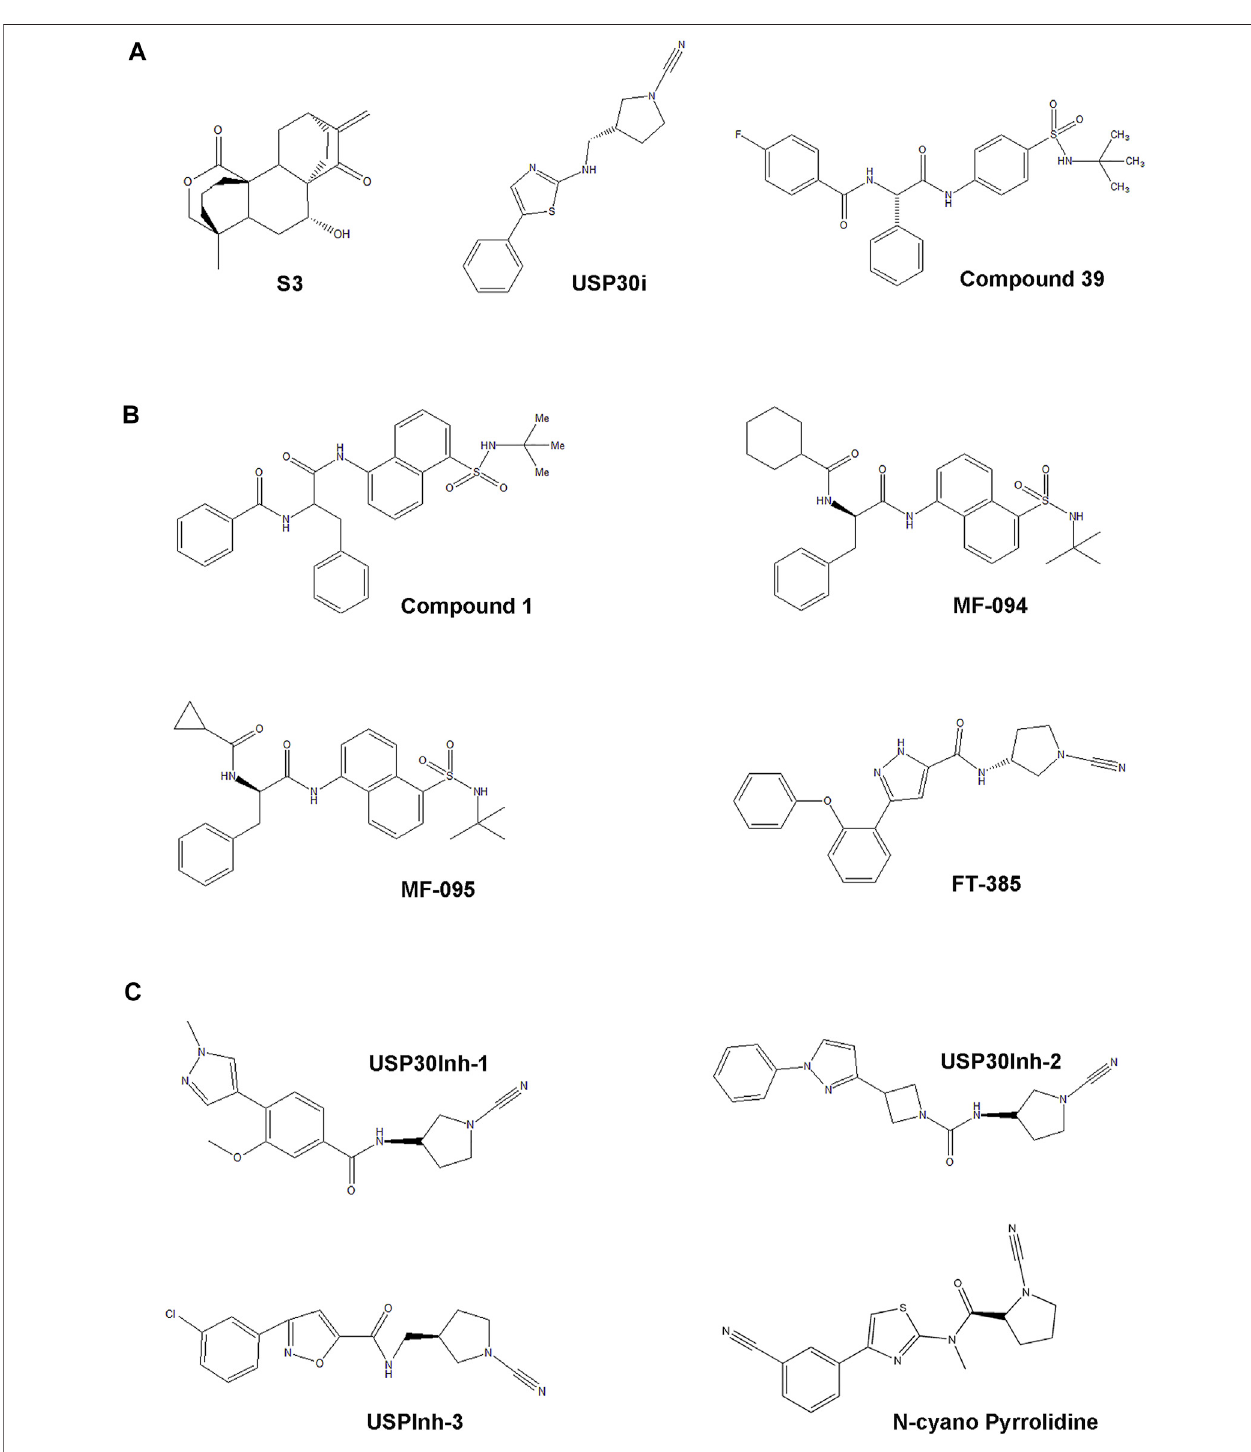
FIGURE3| Thedevelopmentprocessand chemical structure ofUSP30inhibitors .(A) The fi rstsmall naturalcompoundS3wasscreened from300compounds in the cellular level. USP30i is a novel compound. Also, compound 39 is a benzosulphon amide compound characterized from a series of compounds reported in a previous study. (B) The racemic phenylalanine derivative compound 1 was identi fi ed from high-throughput screening, and MF-094, MF-095, and FT-385 were found basedonthestructurerelationshipstudyoftheanalogsderivedfromcompound1. (C) Thecyano-amidecontainingsmall-moleculeUSP30Inh-1,USP30Inh-2,and USP30Inh-3 was synthesized based on the compound structure reported in a previous patent.